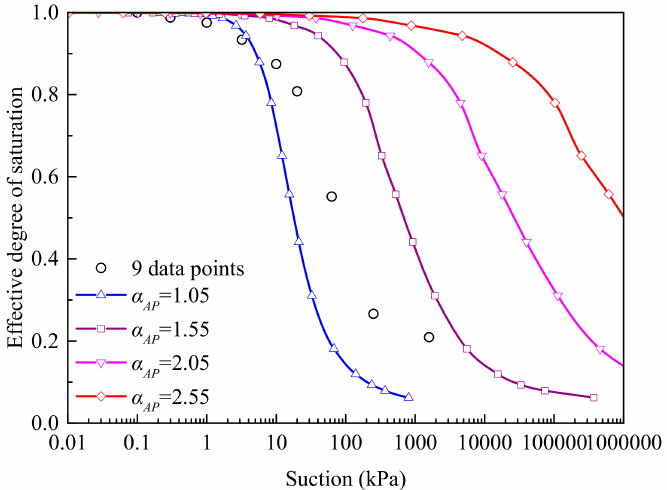
Figure 1. Comparison of the predicted soil-water characteristic curve (SWCC) obtained from Arya and Paris (AP) model applying di ff erent values of scaling